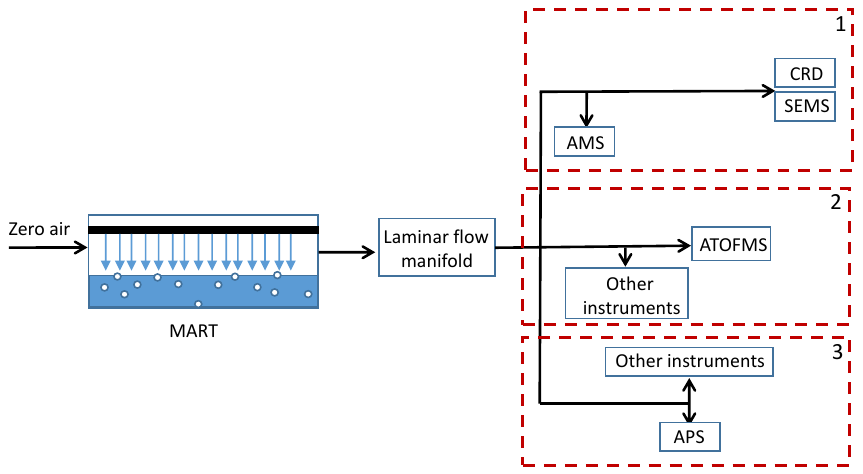
Figure 1. Experimental schematic for MART sampling during the IMPACTS 2014 study, with boxes labeled 1, 2, and 3 corresponding to different sampling